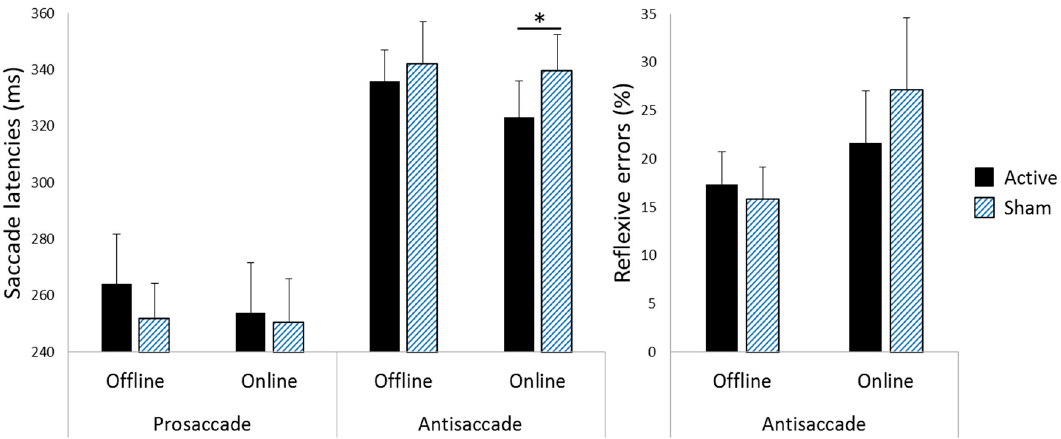
Figure 3. Performance following active versus sham stimulation in the offline and online experiments. Antisaccade latencies were significantly reduced following active compared to sham stimulation in the online, but not the offline, experiment. Bars indicate standard errors. * p = 0.018, BF 10 = 4.493.